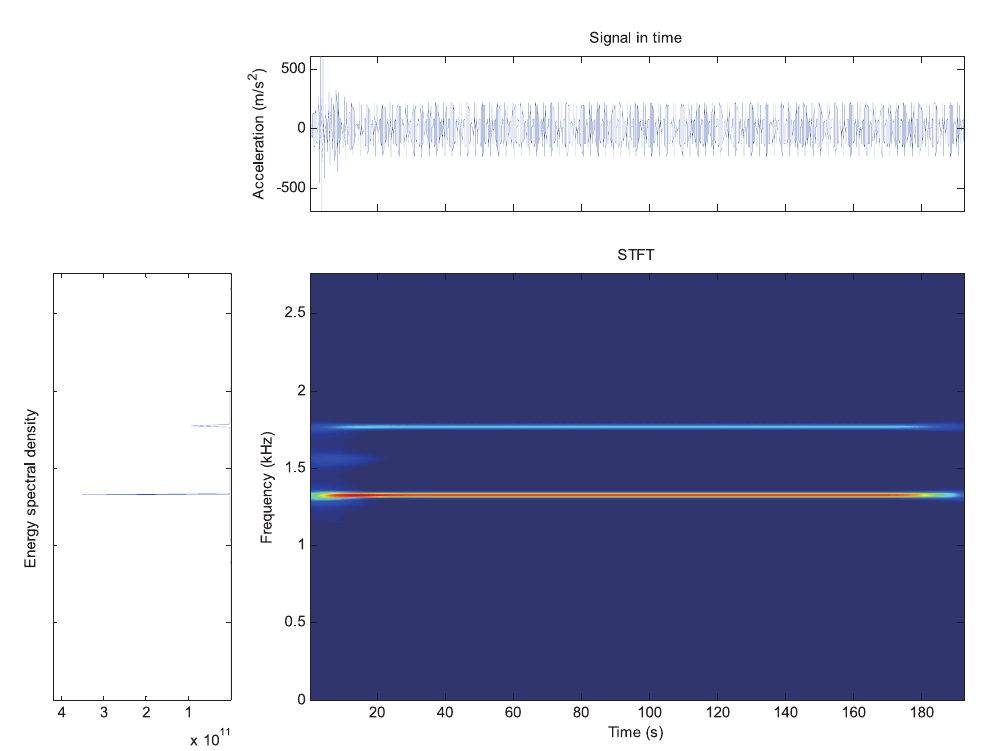
Fig. 11. STFT of the pinion bearing acceleration for a constant applied